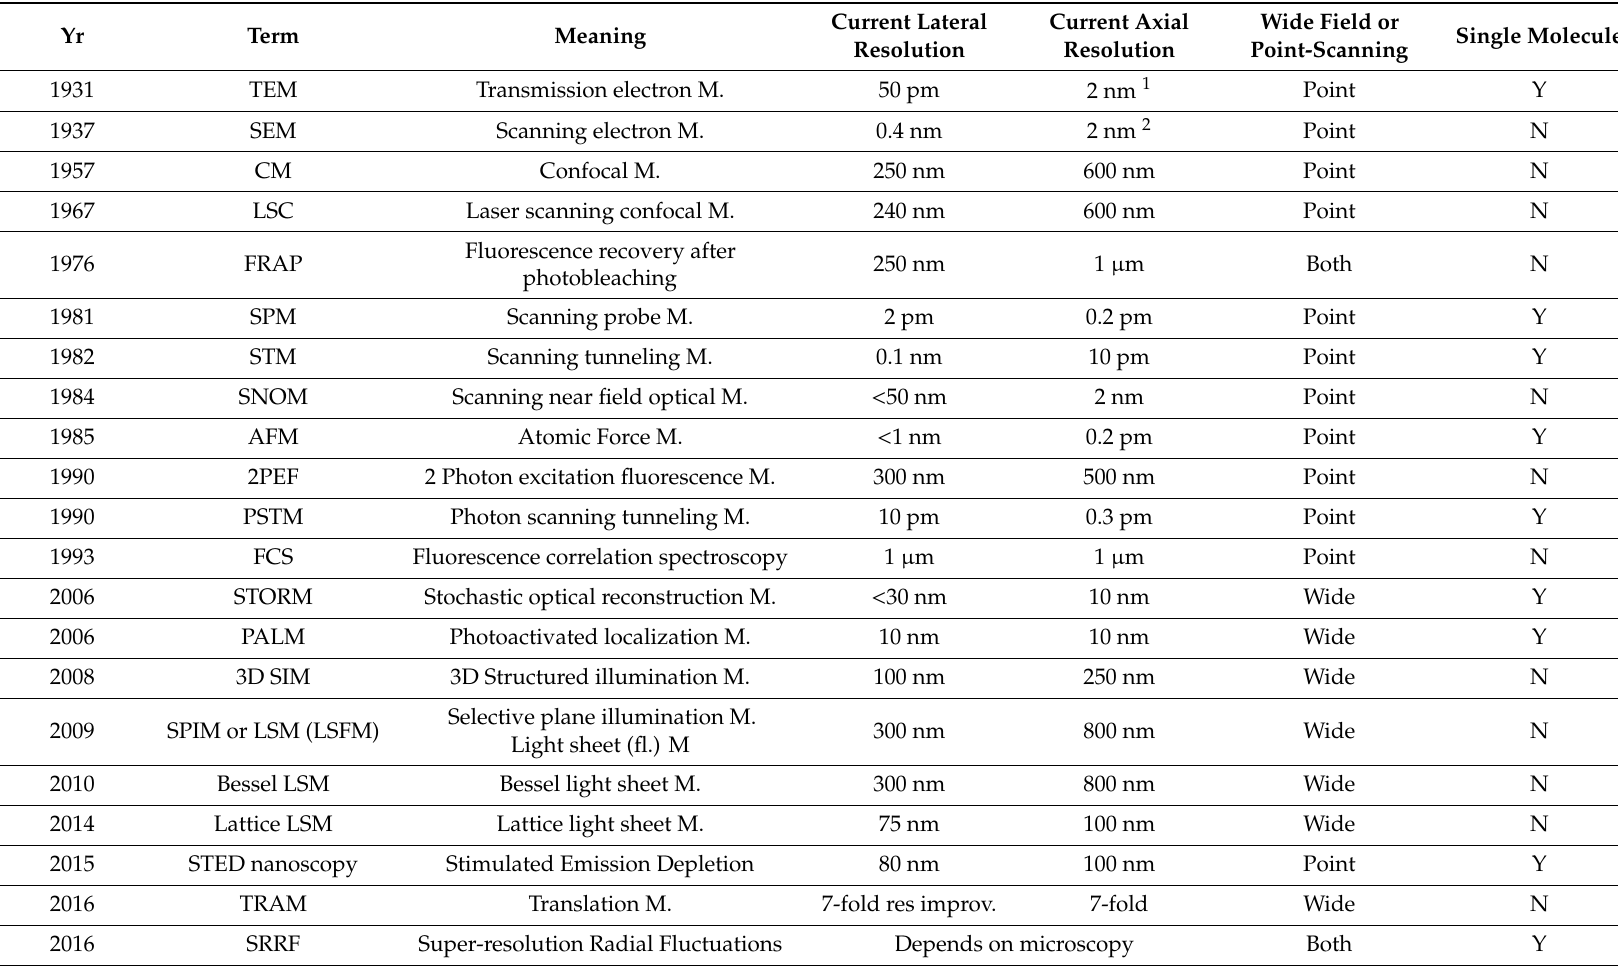
Table 2. Basic microscopy modules, sorted by the year of their first invention. Please note that some of them can be used combinatorically, e.g., PALM / STORM / TRAM / SRRF and LSM ( 1 with tilt series and reconstruction, 2 with